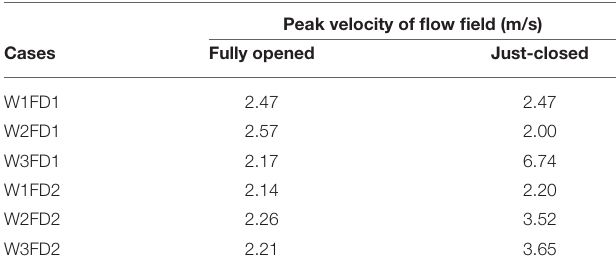
TABLE 4 | Peak velocity of transvalvular flow for the six